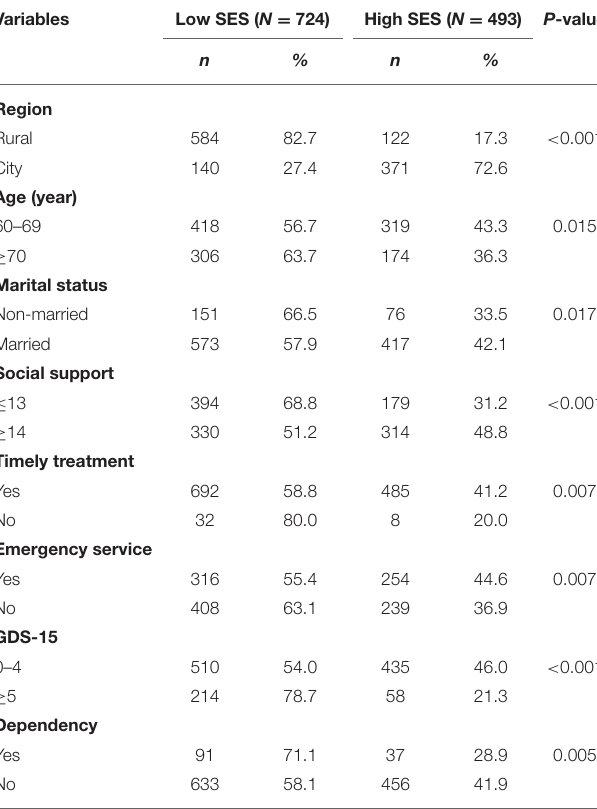
TABLE 1 | Demographic characteristics of the study participants by sex in the study.